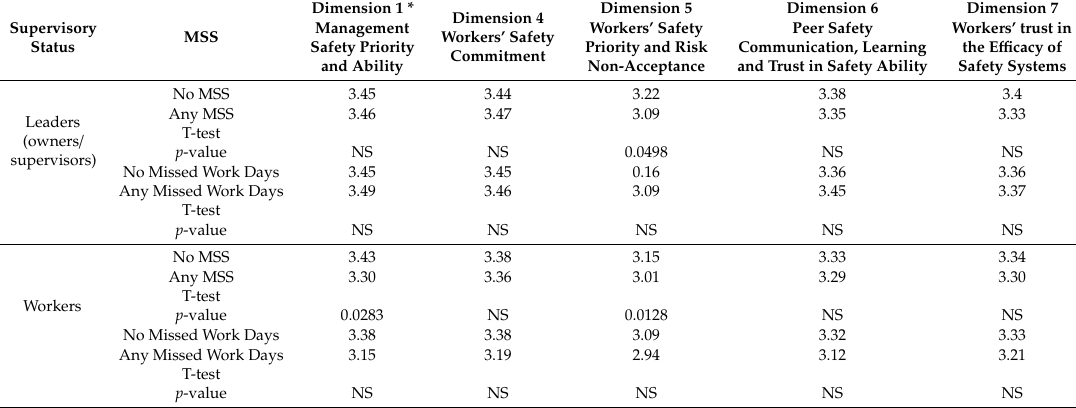
Table 3. Montana logging survey 2017: Safety climate dimension scores by musculoskeletal symptom status